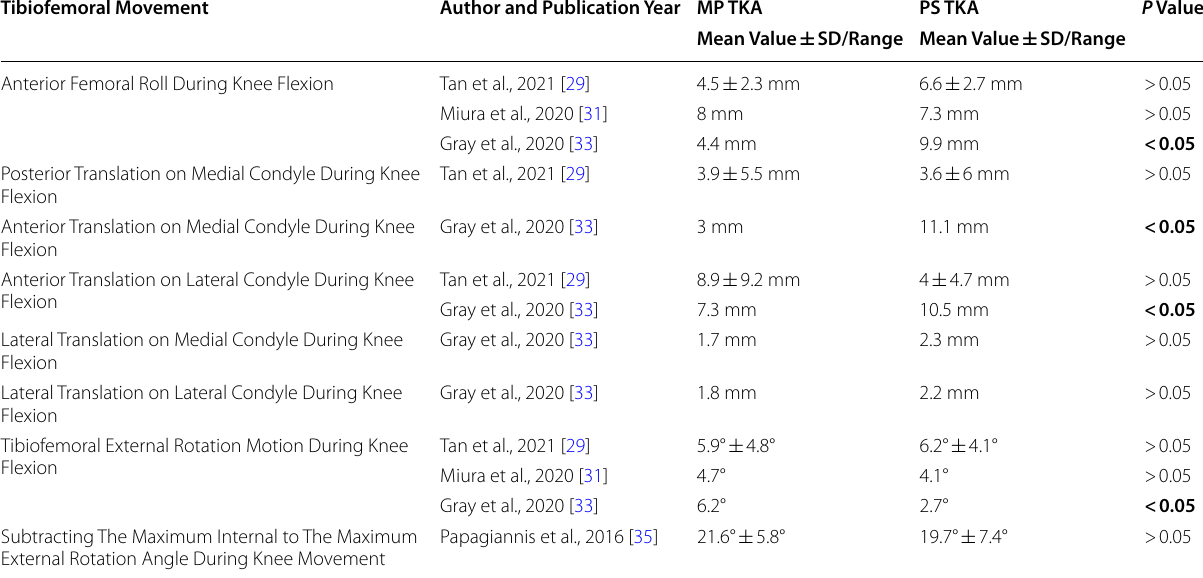
MP Medial pivot, PS Posterior stabilised, SD Standard deviation, mm Millimetres, ° Degree